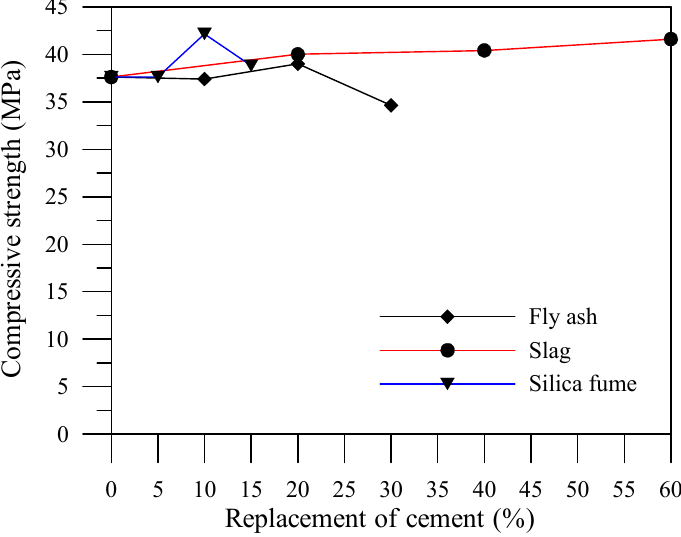
Figure 3. Effects of mineral admixture amount on compressive strengths (56